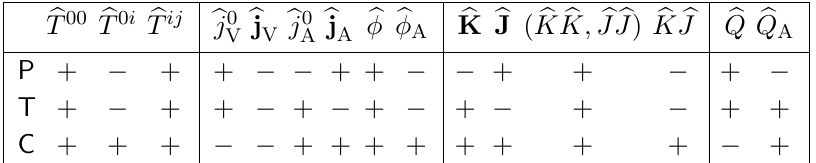
Table 1 . Transformation properties under discrete transformation for various operators in the rest frame. P is parity, T is time-reversal and C is charge conjugation transformation. stress-energy tensor, is a pseudoscalar,